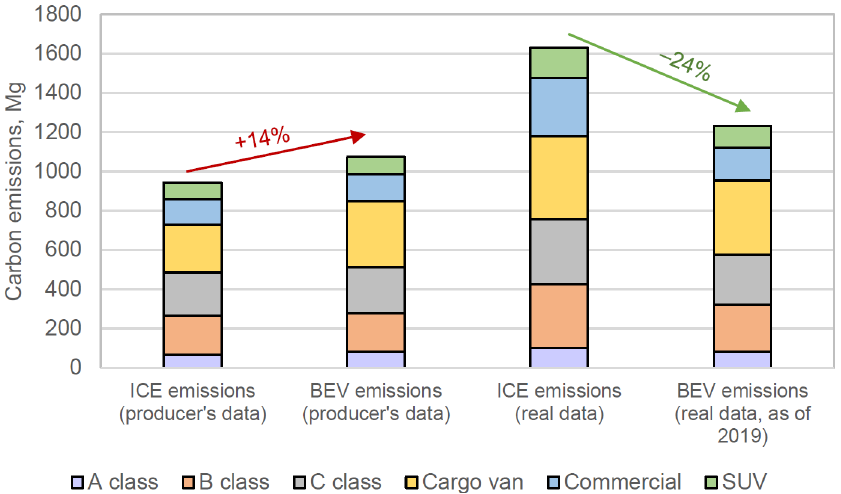
Figure 10. Differences between the impact of fleet electrification on carbon emissions using produc- ers’ data and case study results. data and case study